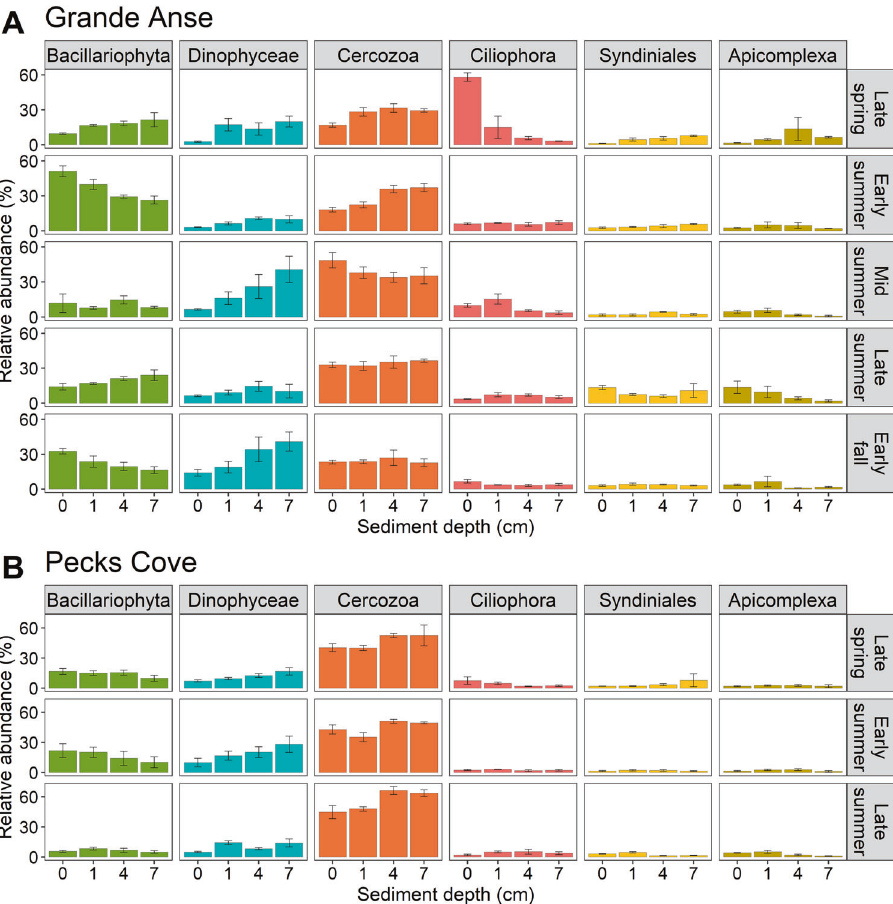
Fig. 3 18S rDNA read abundance (mean ± SE) of dominant protist taxa among depths and seasons in Bay of Fundy mud fl ats in 2019. n = 3 samples, except in early summer (1 cm and 7 cm depths) at Grande Anse ( A ) and late summer (1 cm depth) at Pecks Cove ( B ) where n =